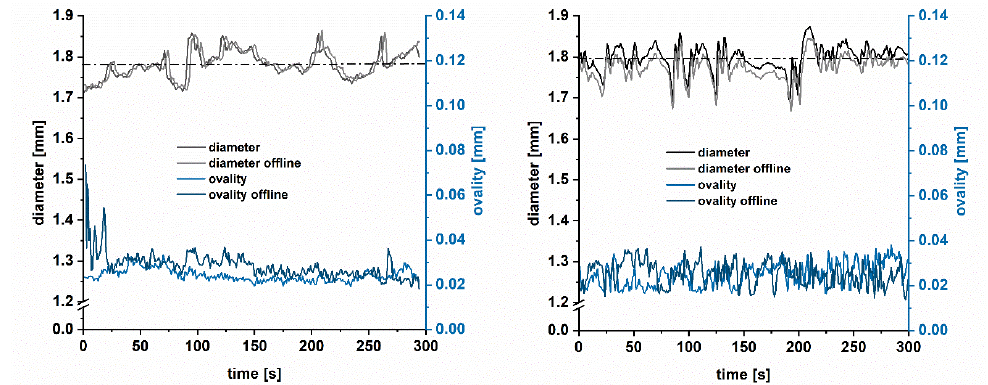
Figure 3. Inline- and offline-determined diameter and ovality (∆Ø max/min ) as a function of time (1 Hz) for each applied PFR = 5 g/min (left); 10 g/min (right). The dashed line marks the mean value of the inline-determined diameter.